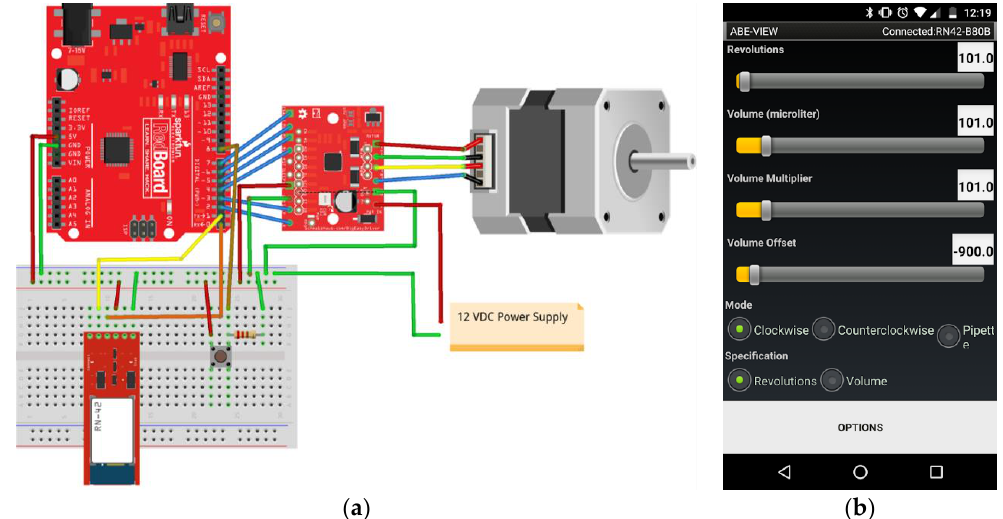
Figure 5. ( a ) Motion control system assembled by students using off-the-shelf components (Sparkfun RedBoard, BlueSMiRF Silver, Big Easy Motor Driver, and 12 V bipolar 200 steps/rev stepper motor), and ( b ) student populated ABE-VIEW interface to control the system to operate the motor to drive a custom pipette/syringe pump.